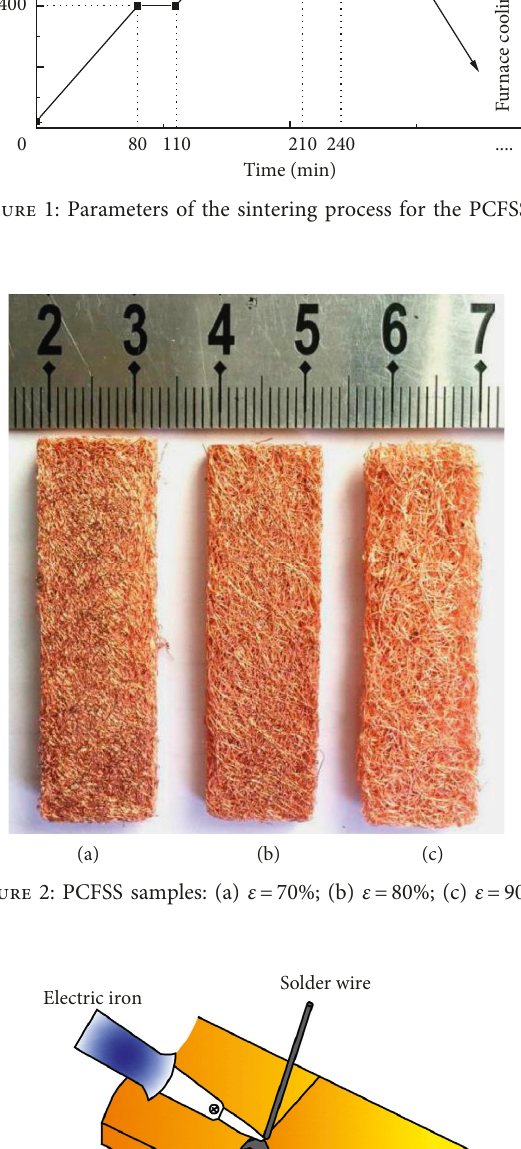
Figure 3: Schematic of the PCFSS soldering